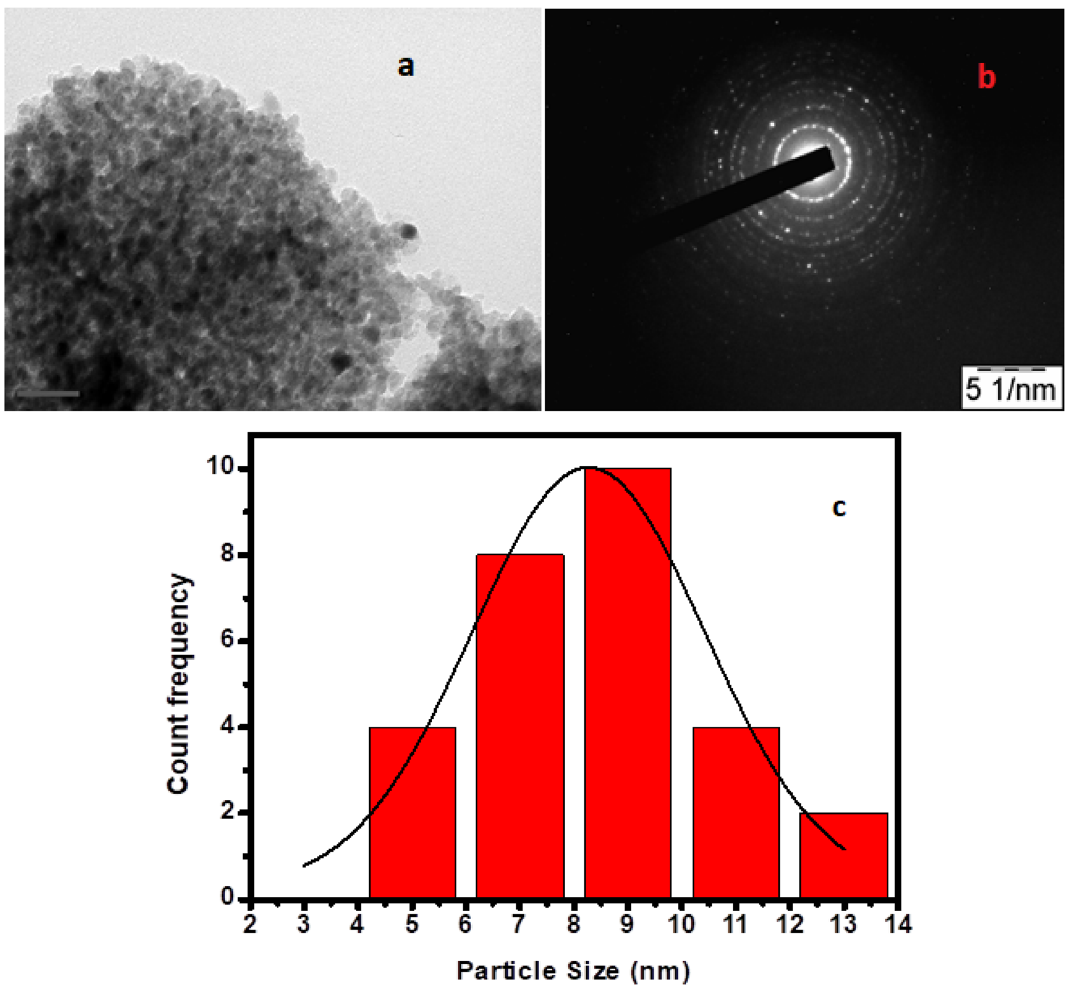
Figure 5. ( a ) TEM, ( b ) SAED image and ( c ) histogram of TANI/Cu 2 O/Ag